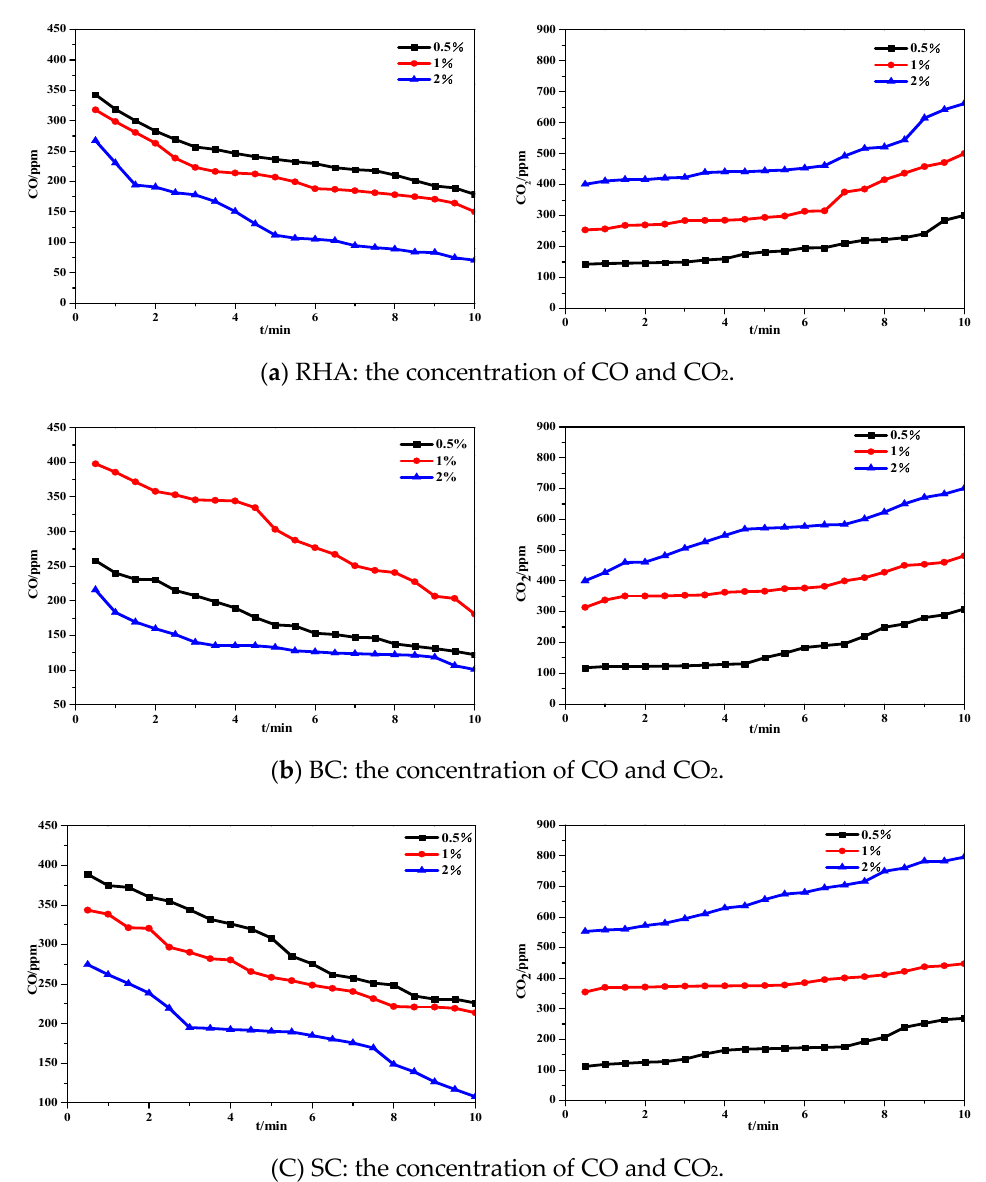
Figure 5. COx concentration produced by the denitration process of the three biochars at different O 2 concentrations.